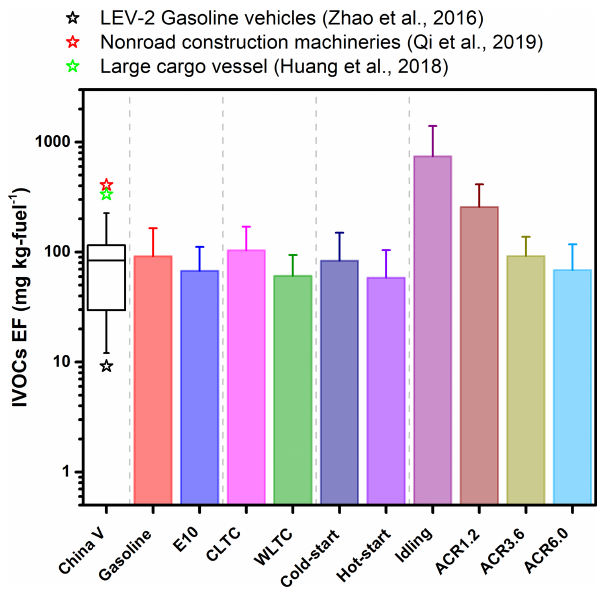
Figure 1. IVOC emission factors measured under different condi- tions, i.e., different fuel type (gasoline and E10), test cycles (China Light-Duty Vehicle Test Cycle, CLTC, and Worldwide Harmonized Light Vehicles Test Cycle, WLTC), starting mode (hot-start and cold-start operation) and acceleration rates (acceleration rates of 1.2, 3.6 and 6.0kmh − 1 s − 1 ). Stars indicate the EF data are from the US, i.e., median US LEV-2 gasoline vehicles (vehicles manufac- tured in 2004–2012), nonroad construction machinery and a large cargo vessel (Qi et al., 2019; Huang et al., 2018; Zhao et al., 2016). The first category “China V” is the compilation of all the EF re- sults from all of the CLTC and WLTC tests. The boxes indicate the median value, with error bars representing 1 standard